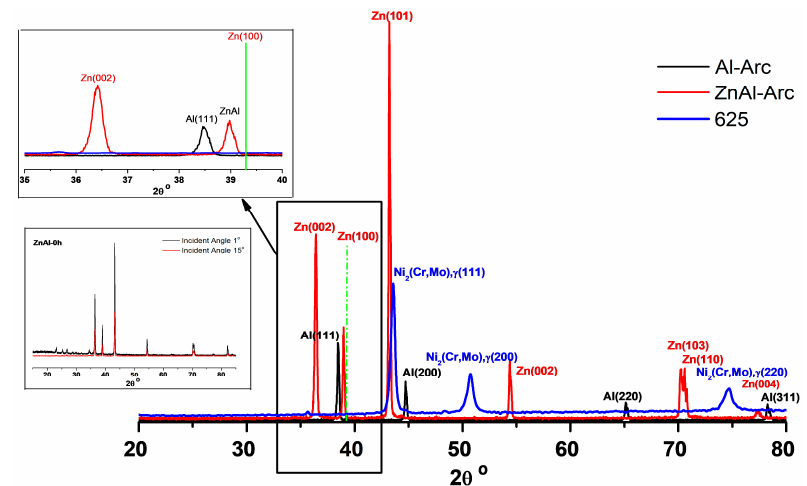
Figure 5. XRD spectra of the crystalline phases of the Al–Arc, ZnAl–Arc, and Inconel 625 alloy coatings.